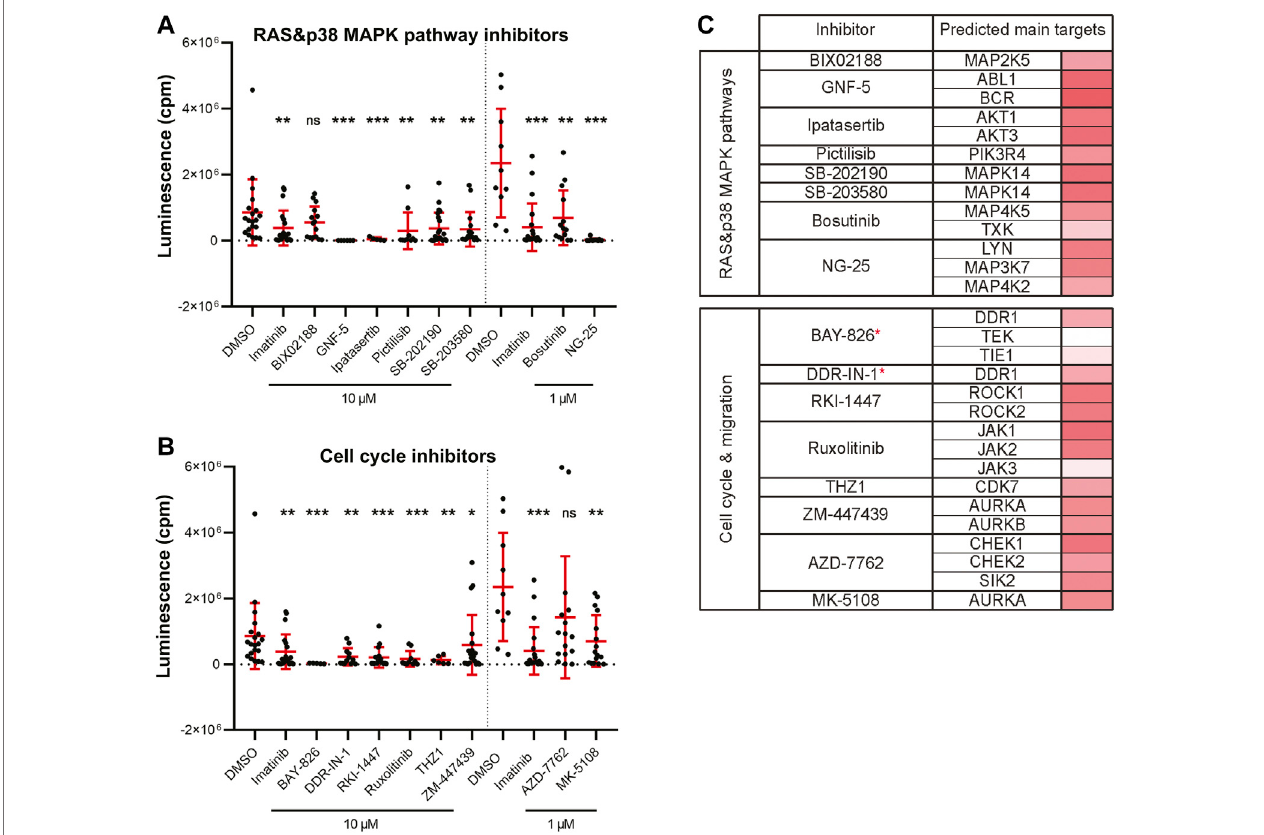
FIGURE 4 | Kinase inhibitor active in transplanted leukemia K562 cells. (A) Inhibitors that targeted the RAS and p38 MAPK pathways and signi fi cantly inhibited leukemiacellgrowth invivo . (B) Inhibitorsthattargetedcellcycleandcellmigrationrelatedproteinsandsigni fi cantlyinhibitedleukemiacellgrowth invivo . (A,B) Statistical signi fi cancewasdeterminedbyMann-Whitneytest.* p < 0.04,** p < 0.002,*** p < 0.001.Luminescencemeasured invivo insingleembryosisrepresentedbyasingledot in dot plots. All experiments were done in 2 – 3 repeats. (C) List of all the inhibitors from A-B with their predicted main protein targets in human K562 cells. The last column with red bars on the right represents the average expression of individual target genes in human cells which was extracted from a publicly available RNA- sequencing dataset. Inhibitors with a potent new function in leukemia are labeled with a red